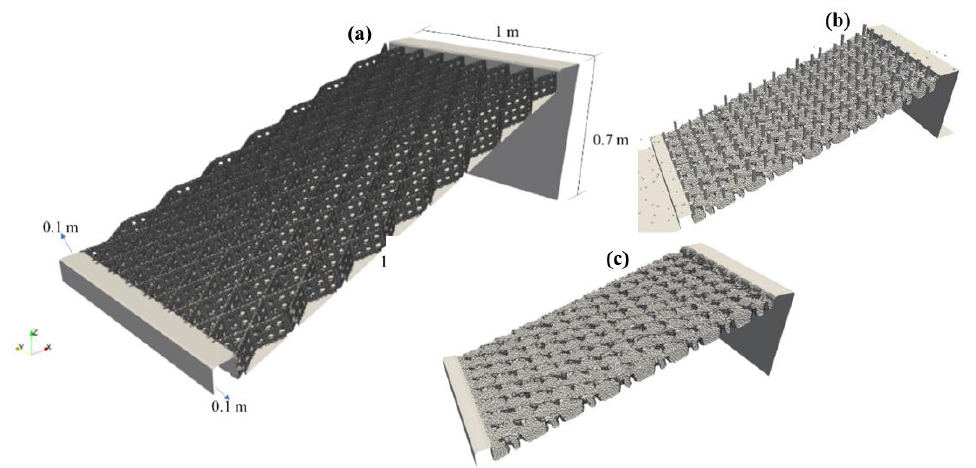
Figure 3. Schematic diagram of the model adding generalized plants. ( a ) Honeycomb-type revetment without gravel and vegetation; ( b ) Honeycomb-type revetment with rigid vegetation; ( c ) Honeycomb-type revetment without rigid vegetation.